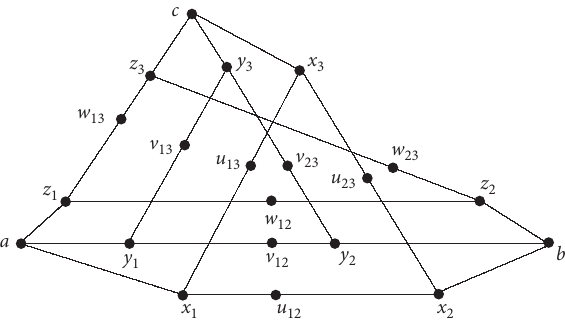
Figure 3: A graph G with c